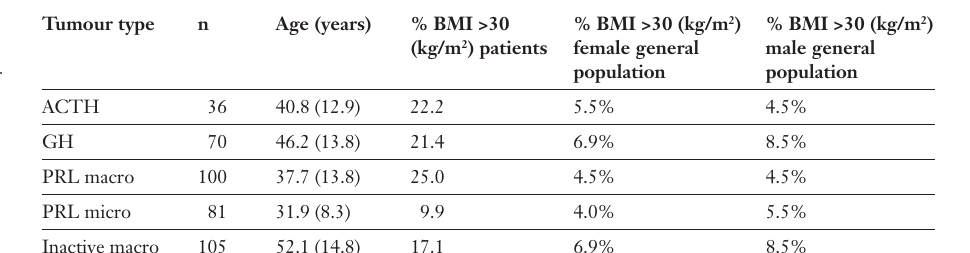
Figure 1 Distribution of BMI in relation to age for patients with macro- prolactinoma, micro- prolactinoma, and endocrine inactive